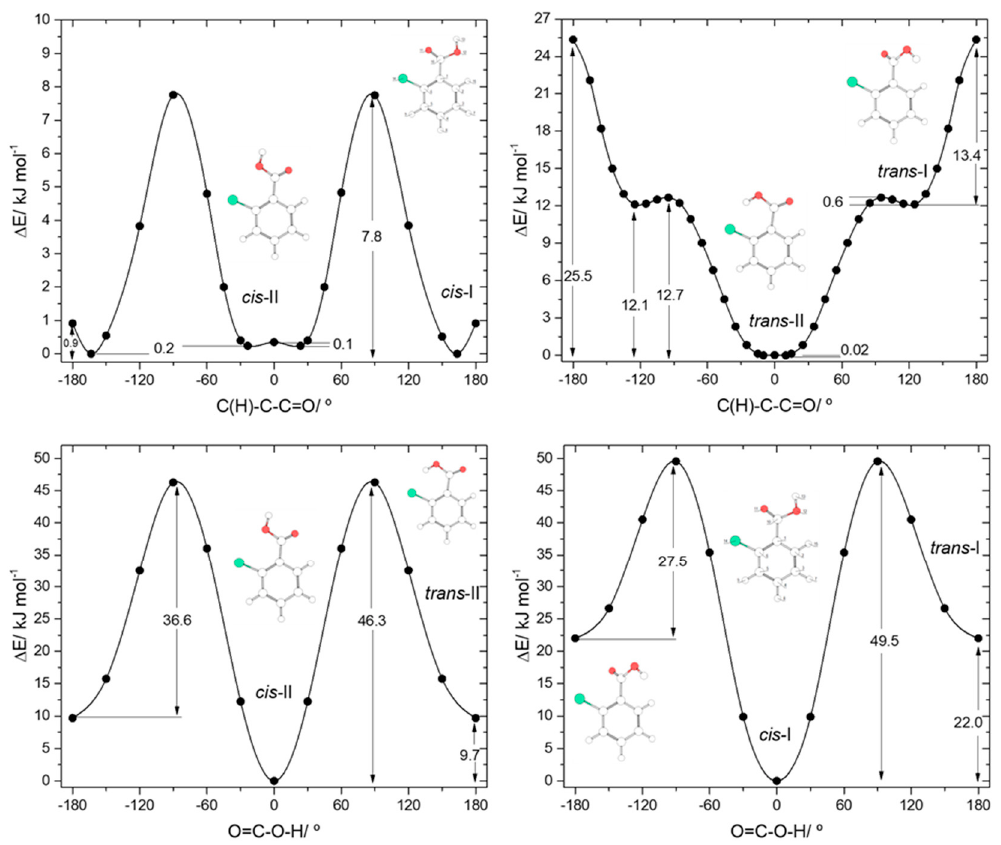
Figure 5. B3LYP/6-311++G(d,p) calculated potential energy profiles for internal rotation about the exocyclic C-C (for cis and trans arrangement of the carboxylic group) ( top left and top right panels ) and about the C-O bond (connecting the two pairs of conformers, cis -II/ trans -II and cis -I/ trans -I; bottom left and bottom right panels ) for 2-chlorobenzoic acid.